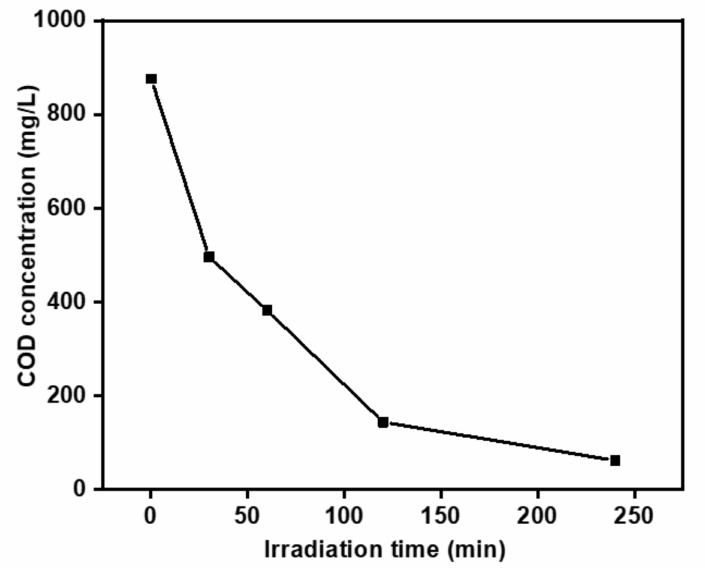
Figure 11. Chemical oxygen demand (COD) removal of P-AgC (13).